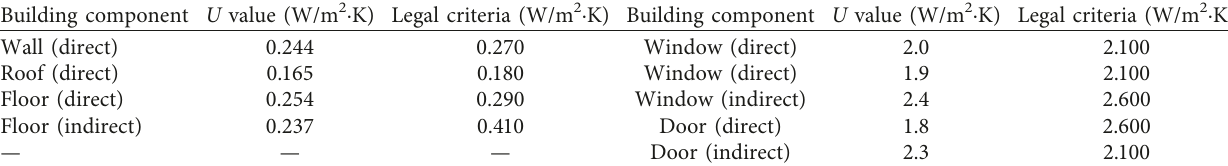
Table 6: Envelope performance of the target building.